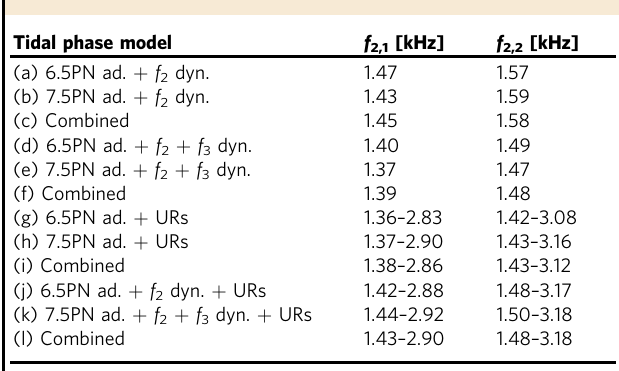
Table 1 Marginalised 90% lower bound or 90% credible interval of the quadrupolar f -mode frequencies